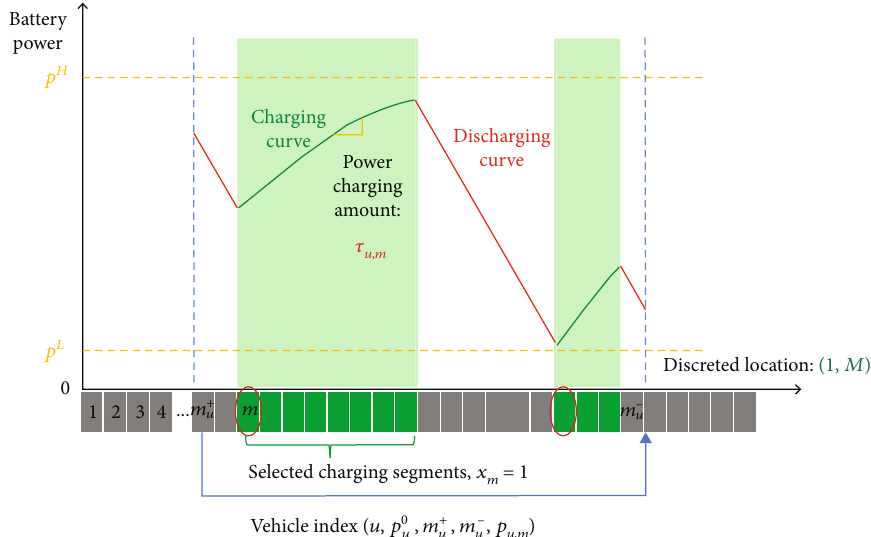
Figure 4: Charging and discharging